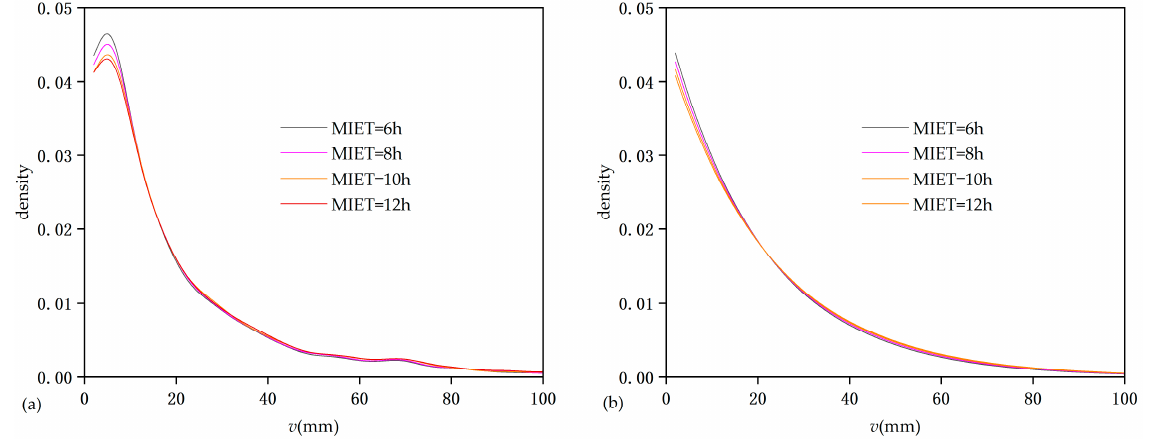
Figure 4. ( a ) The KDE-based PDFs for rainfall event volume v with different MIETs and fixed v t = 2 mm at Jinan; ( b ) the theoretical exponential PDFs of rainfall event volume v with different MIETs and fixed v t = 2 mm at Jinan.